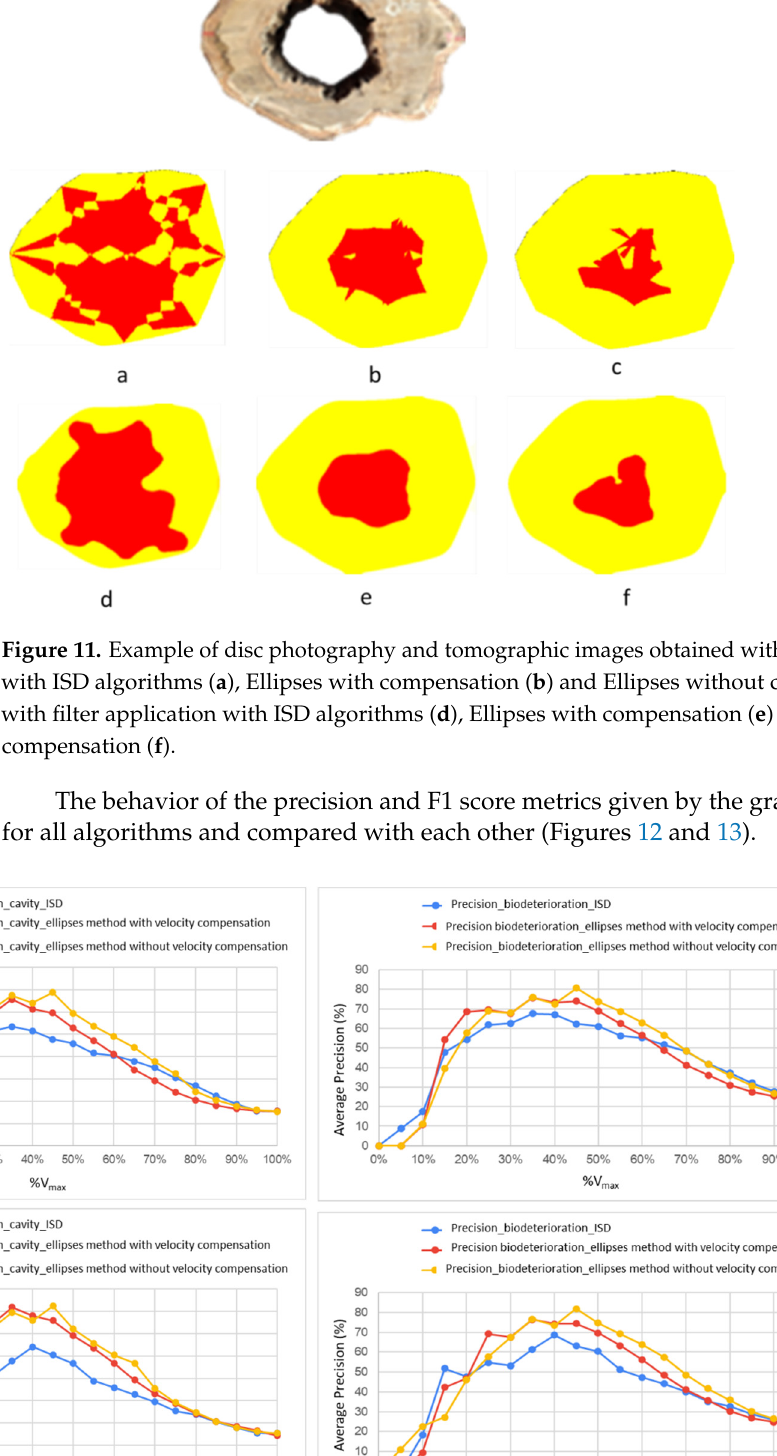
Figure 10. Behavior of the accuracy metric obtained with the application of the confusion matrix for the cavity and the cavity plus biodeterioration as zones of interest, without the application of filters (upper graphs) and with the application of filters (lower graphs).